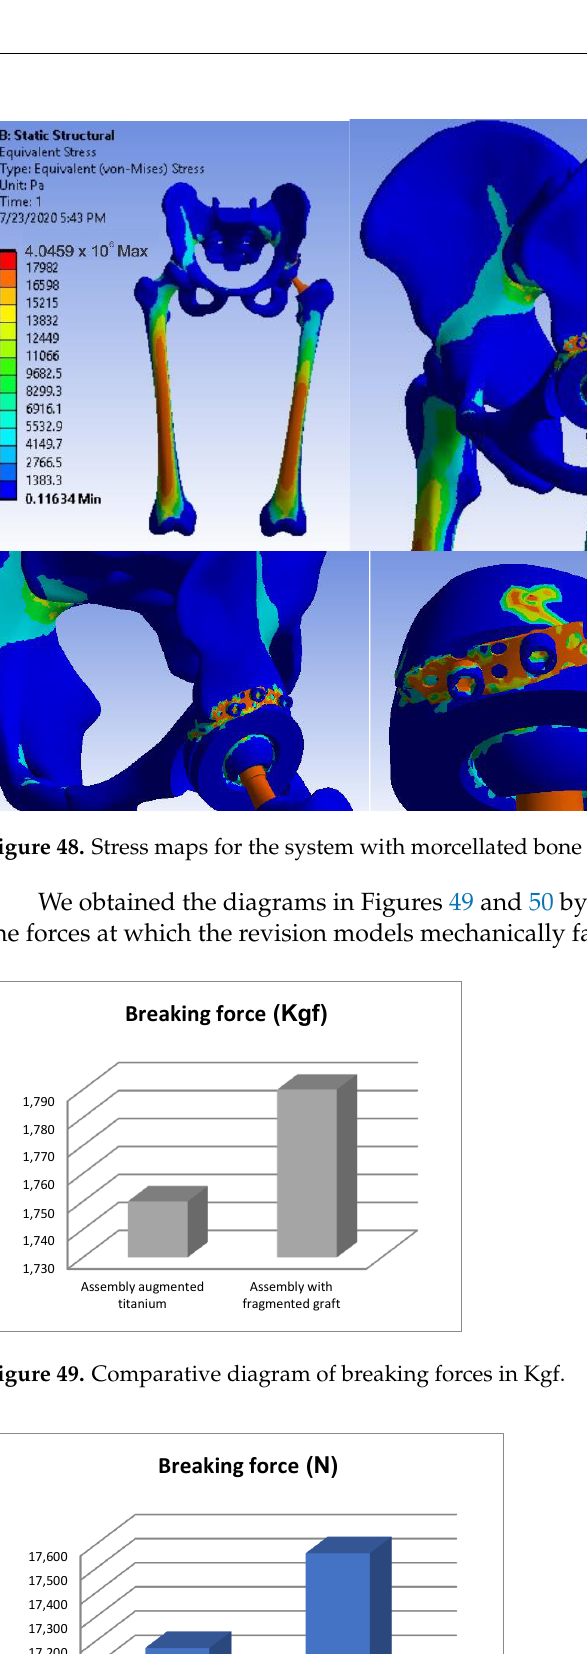
Figure 47. Strain map for the system with morcellated bone graft.